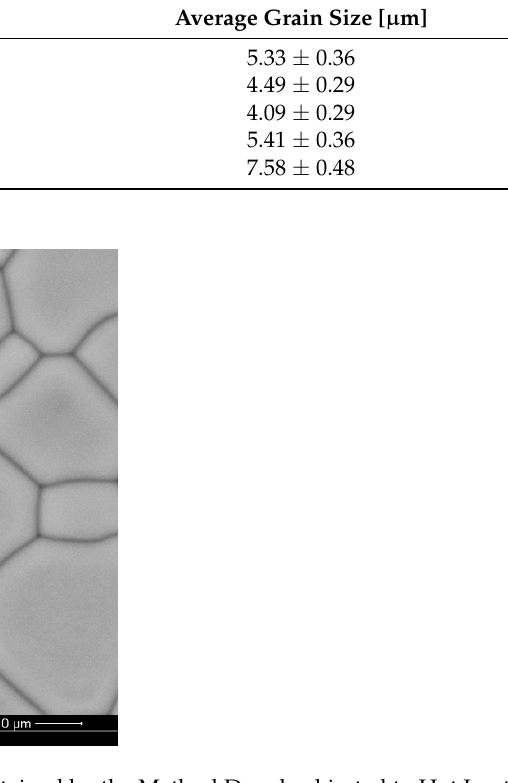
Figure 5. SEM micrographs of materials obtained by the Method D and subjected to Hot Isostatic Pressing (HIP). Pressing